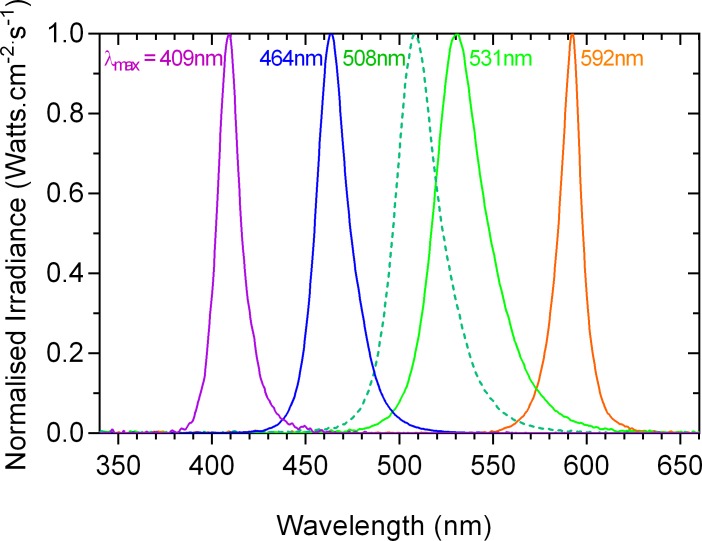
Spectral output of the primary lights.The bandwidths at half maximum output (in nm) are specified in parentheses after the dominant wavelengths (in nm) of the primary lights: 409 (14), 464 (20), 508 (27), 531 (31) and 592 nm (14 nm).